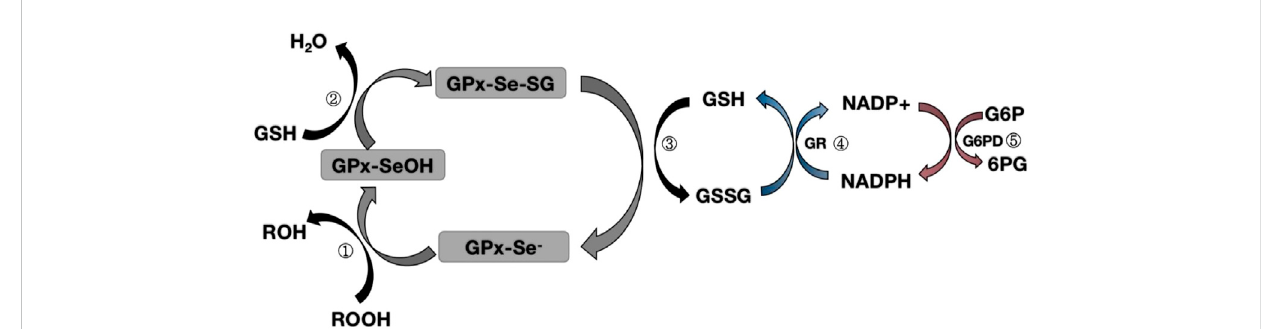
FIGURE 1 Map of the mechanism of glutathione peroxidase redox pathway.Step ① : Selenol (-Se - ) in GPX is oxidized to selenic acid (-Se-OH) by peroxide (ROOH);Step ② :The fi rstGSHmoleculereducesselenicacid(-Se-OH)toformglutathioneatedselenolintermediate(-Se-SG)andreleasesapartofH 2 O; Step ③ :ThesecondGSHmoleculecontinuestoreducetheintermediate(Se-SG)toformoxidizedglutathione(GSSG),whiletheactivityofGPXneutrality returns to selenol (-Se - );Step ④ : Oxidized glutathione (GSSG) is degraded to reduced glutathione (GSH) under the action of NADPH-dependent glutathione reductase (GR), while NADPH loses an electron to NAPD + .Step ⑤ : Glucose 6 phosphate (G6P) reduces NAPD + to NADPH when circulating under the action of glucose 6 phosphate dehydrogenase